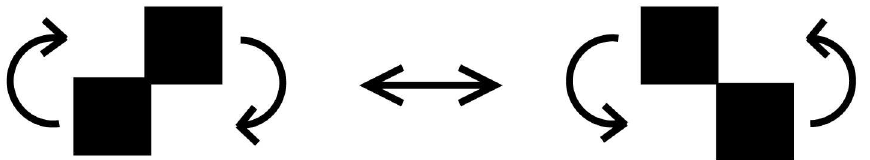
Fig 1. Checkerboard units of 2 × 2 values with ones shown in black and zeros shown in white. The schematic descriptionshows how by swappingelements inside the unit it is possibleto switch between the two units without changingmargin